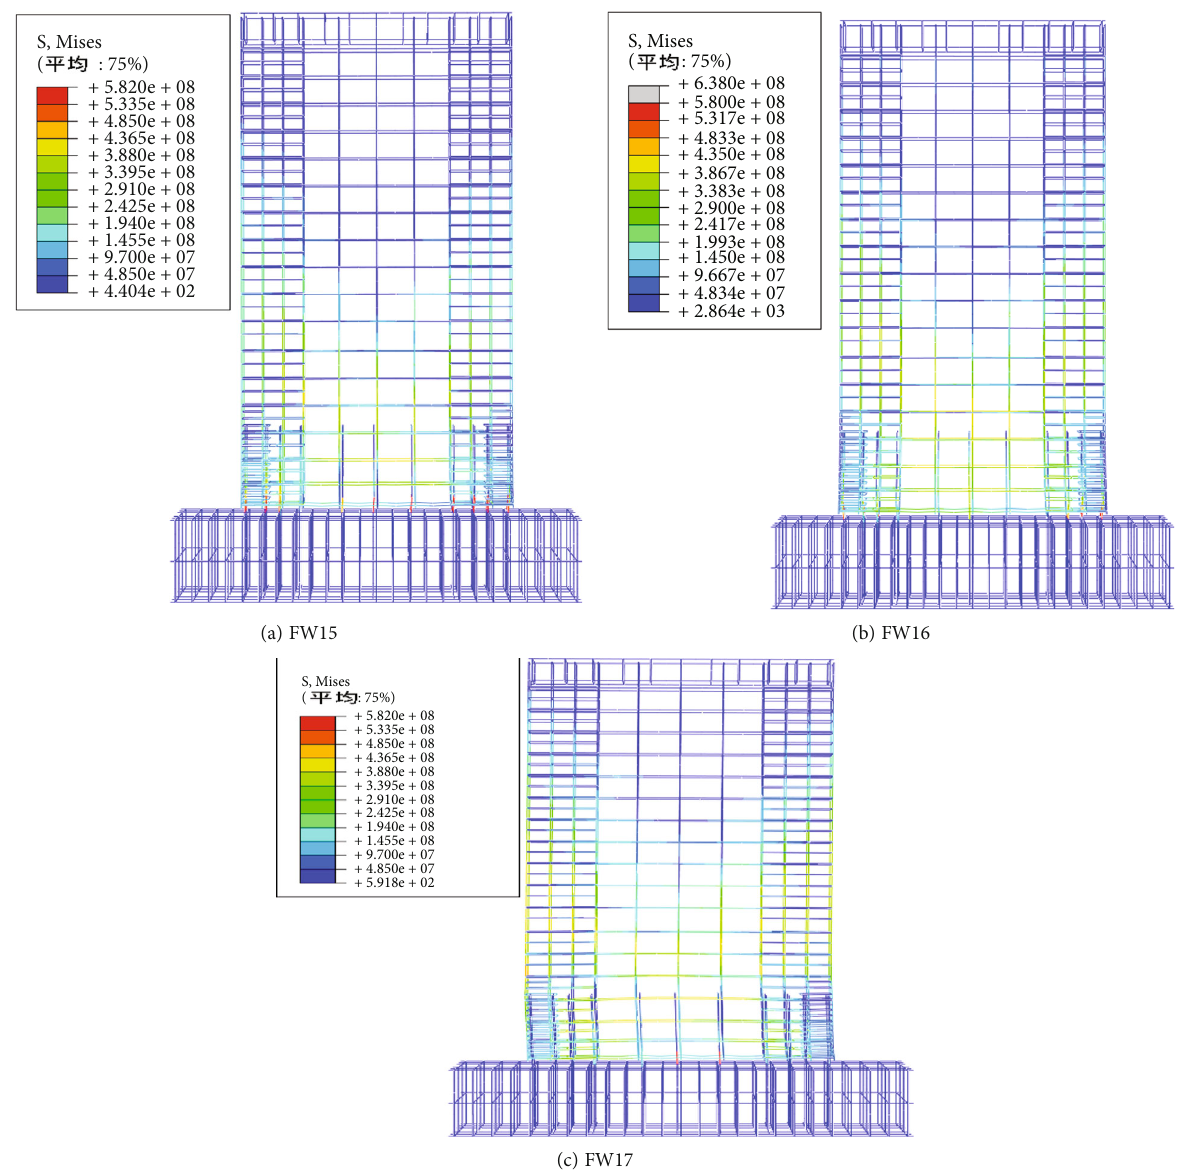
Figure 14: Reinforced stress cloud map for